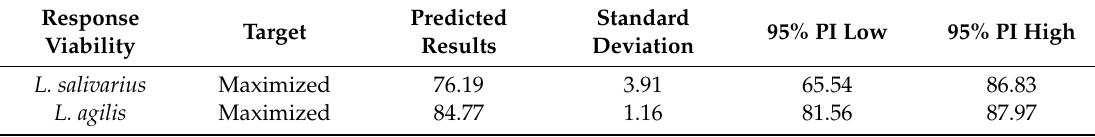
Table 3. Optimum process and validation experiment results at a 95% confidence